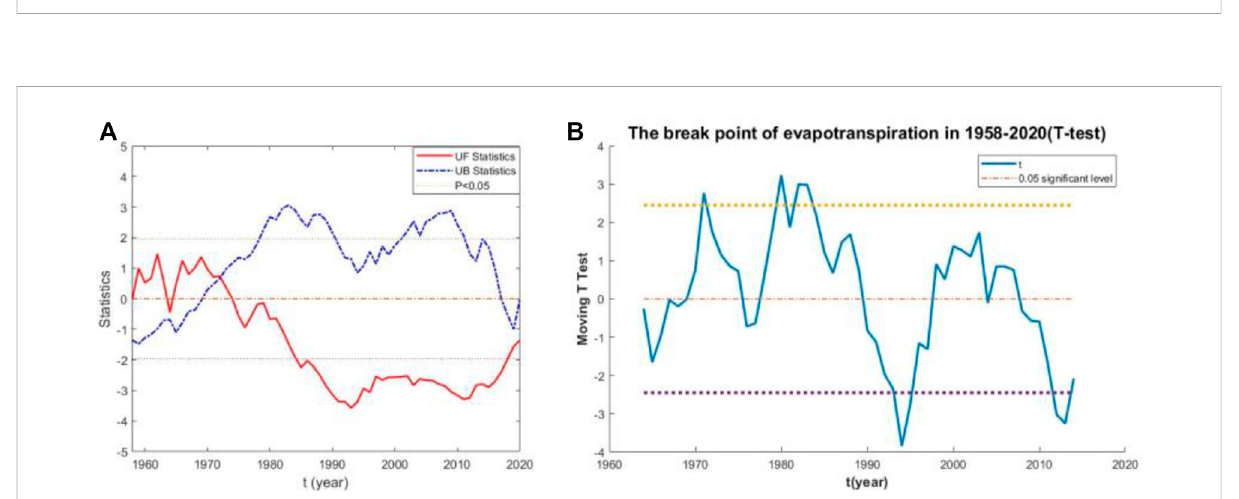
FIGURE 5 Temporal mutation characteristics of the ET 0 : (A) the M – K test; (B) the moving T-test.